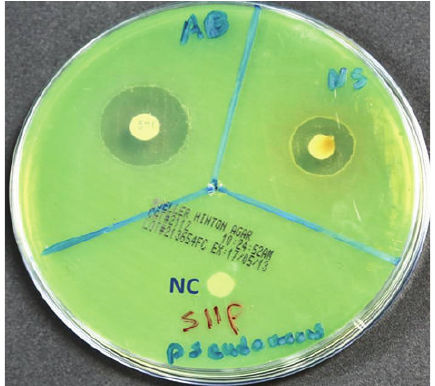
Figure 5: Zone of inhibition of silver nanoparticles produced by S11P against P. aeruginosa (ATCC 27853). NS: silver nanoparticles, AB: antibiotic of choice (gentamicin), and NC: negative control.